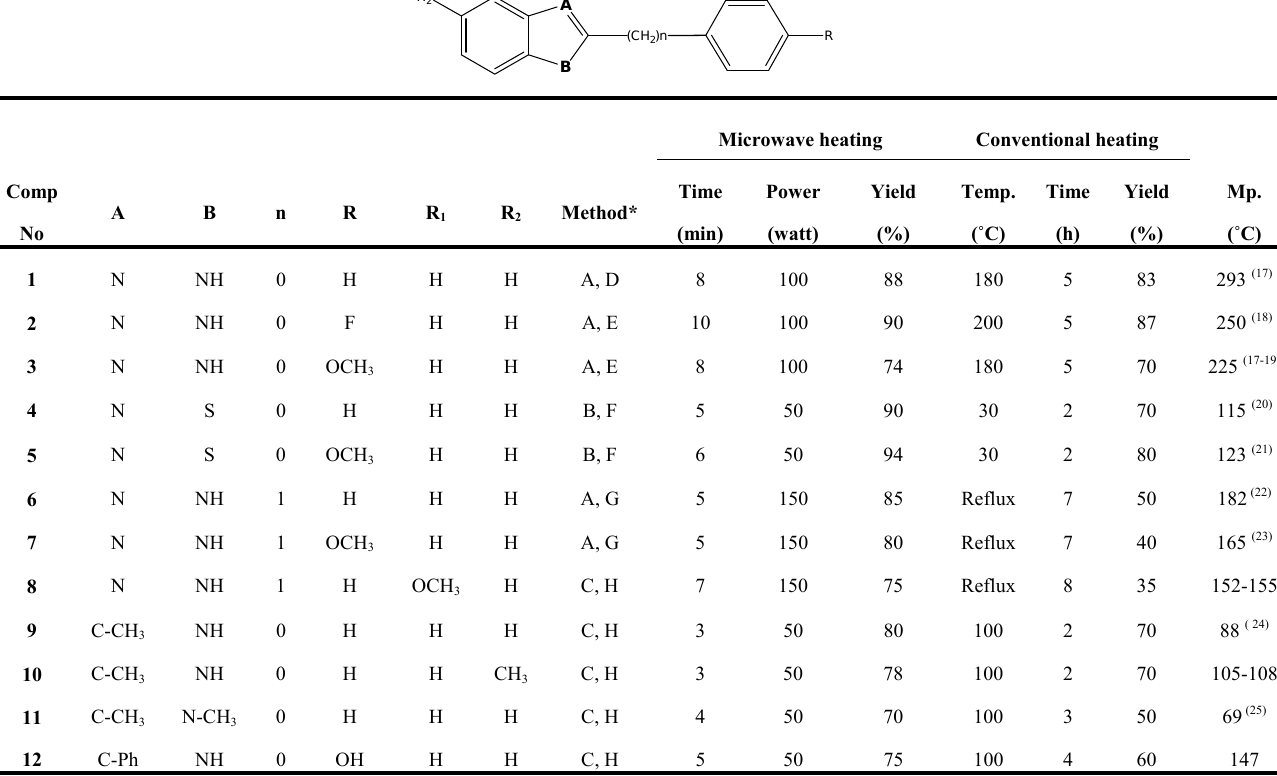
Table 2 . Chemical structures of all synthetic compounds and their synthetic